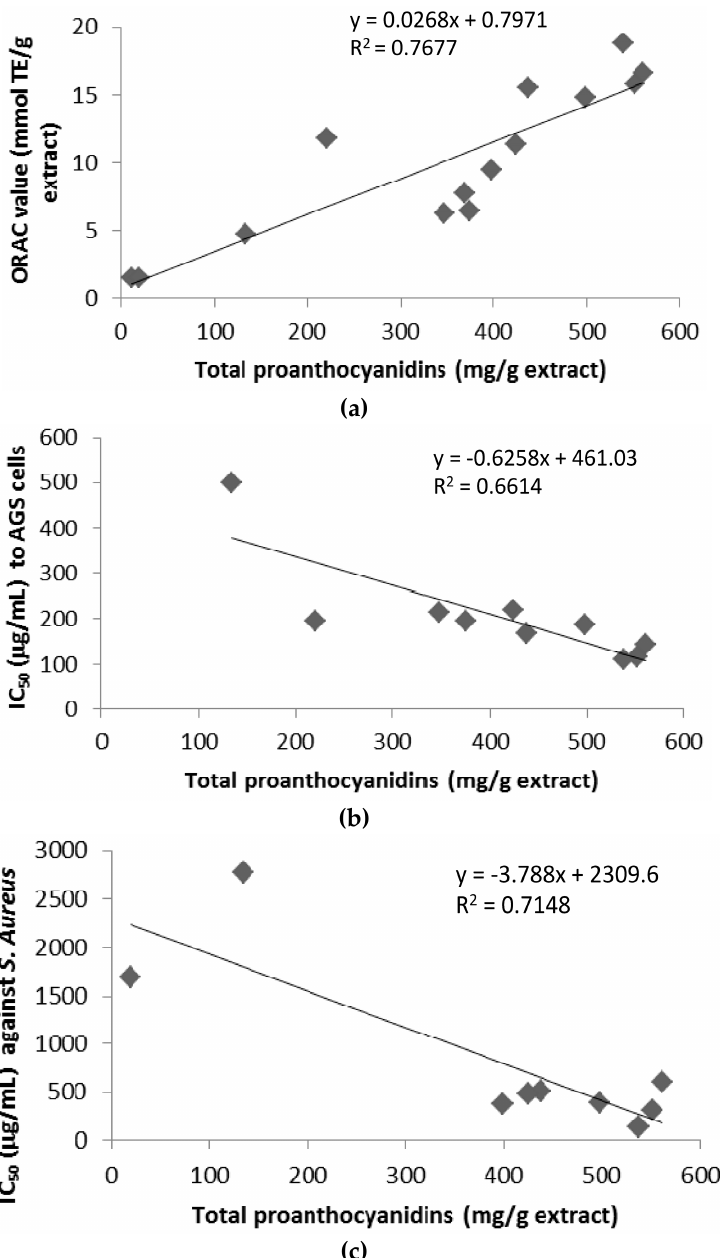
Figure 6. Linear correlation between total proanthocyanidin content and antioxidant capacity (ORAC value) ( a ), citotoxicity (IC 50 ) to AGS cells ( b ), and antimicrobial activity (IC 50 ) against S. aureus ( c ) of U. tomentosa extracts.